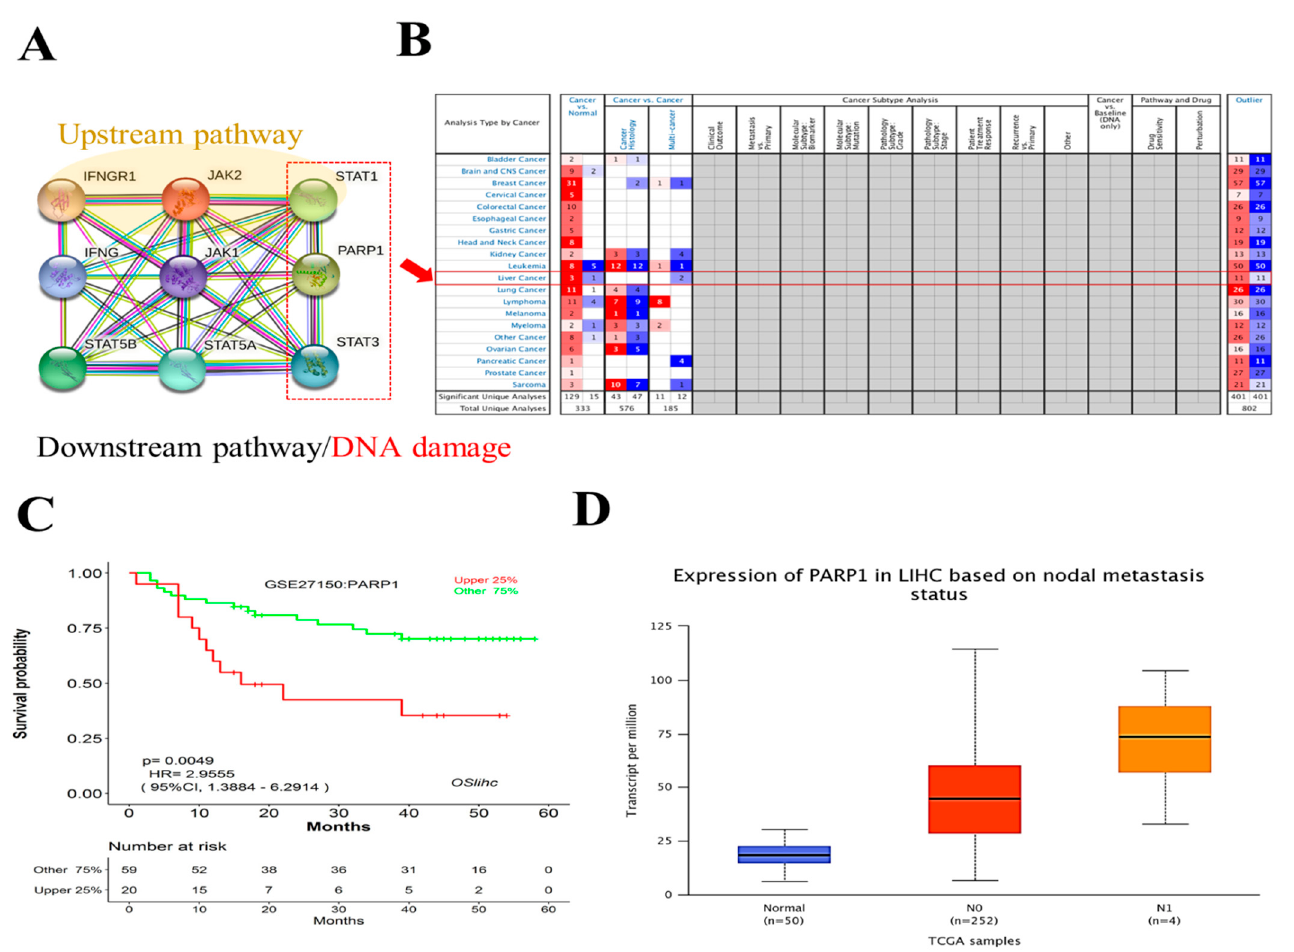
Figure 6. PARP1 expression associated with poor liver cancer patients’ overall survival. ( A ) Schematic representation of the interaction of the IFNGR-JAK-STAT1-PARP1 signaling proteins with the STRING analysis. ( B ) Transcription level of PAPR1 in different types of cancers (oncomine and TCGA) types. ( C ) K-M plot denoting the overall survival of liver cancer patients. ( D , E ) Expression and correlation analysis of PARP1 in liver cancer.